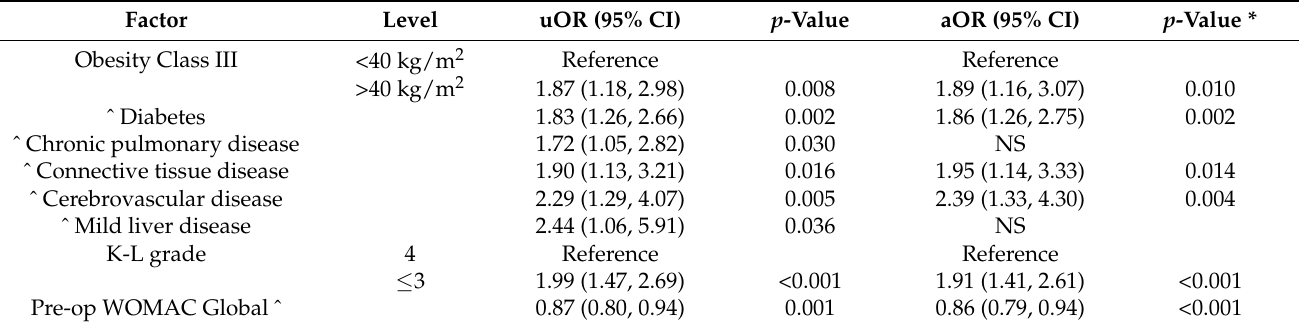
Table 2. Predictors of non-response to